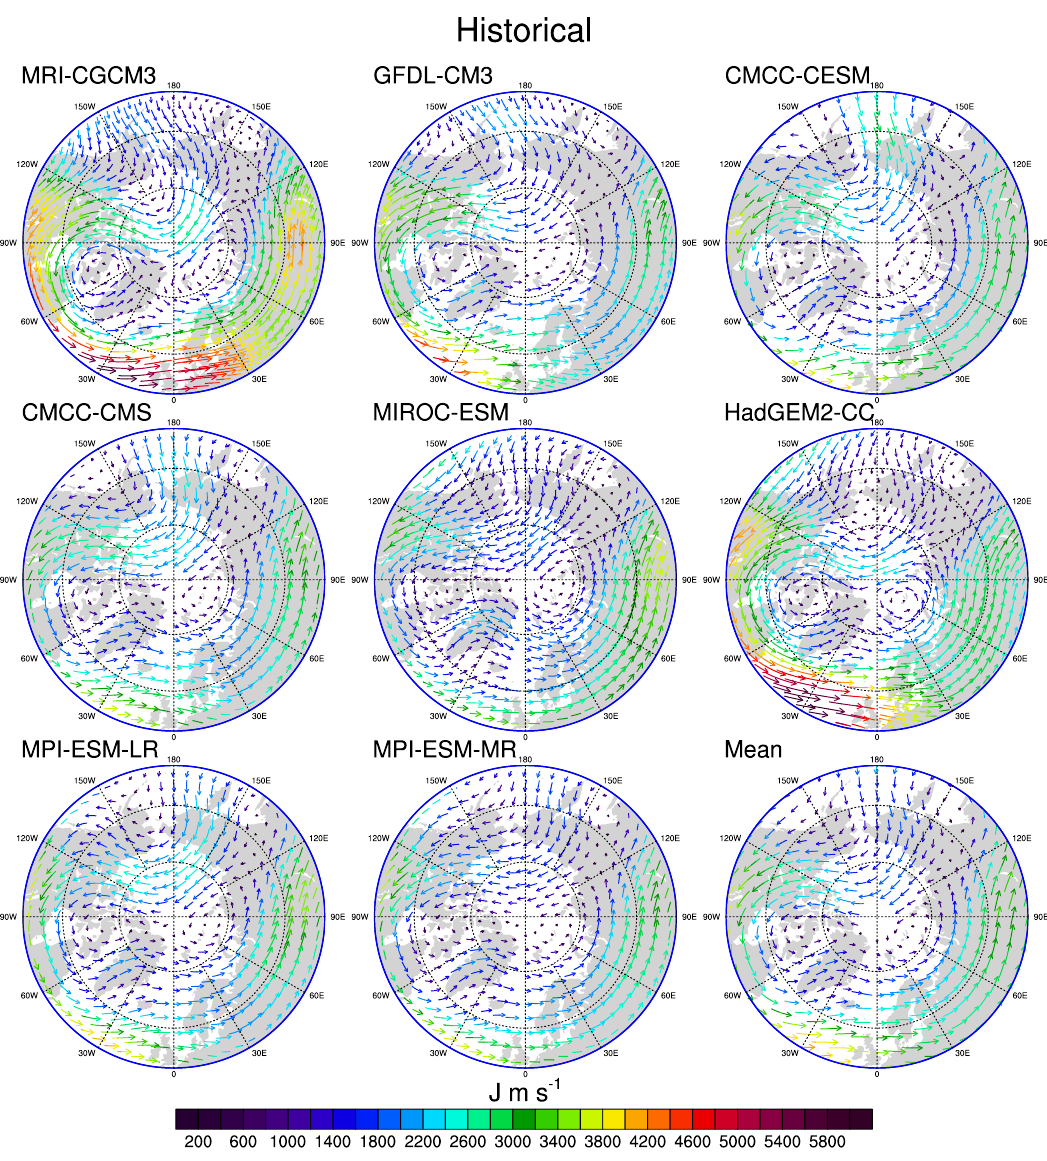
Figure 3. Same as in Figure1, but for the Pacific pathway.